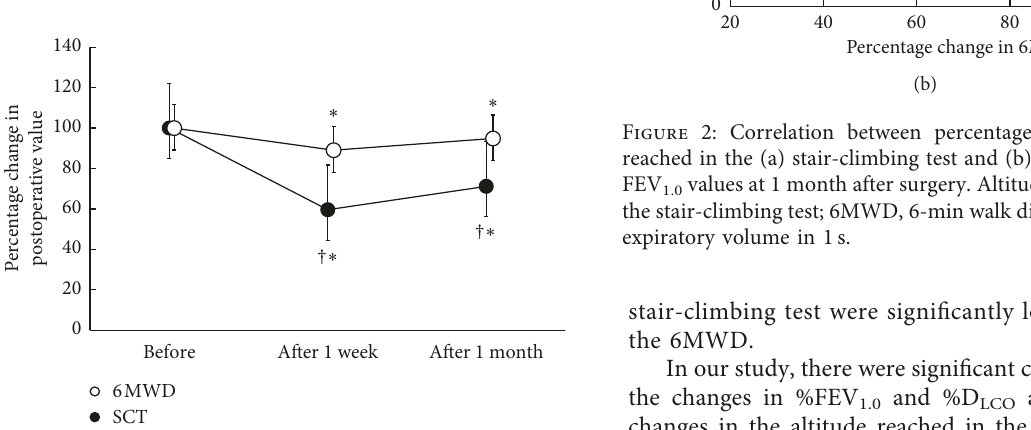
Figure 1: Percentage changes in postoperative SCT and 6MWD values compared with preoperative values. SCT, stair-climbing test; 6MWD, 6-min walk distance. Values are expressed as mean ± standard error. ∗ p < 0 . 05: compared with preoperative values. † p < 0 . 05: SCT versus